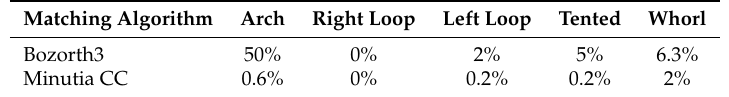
Figure 6. Evolution of attack efficiency taking into account all fingerprint classes for the two biometric systems. Table 5. Probability value of a successful attack FAR A for each fingerprint class for the two matching